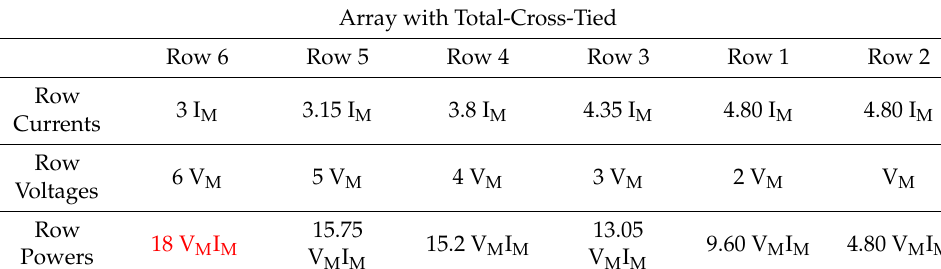
Table 2. Summarized mathematical estimation of current, voltage and power values of the PV array under partial shading S2. Array with